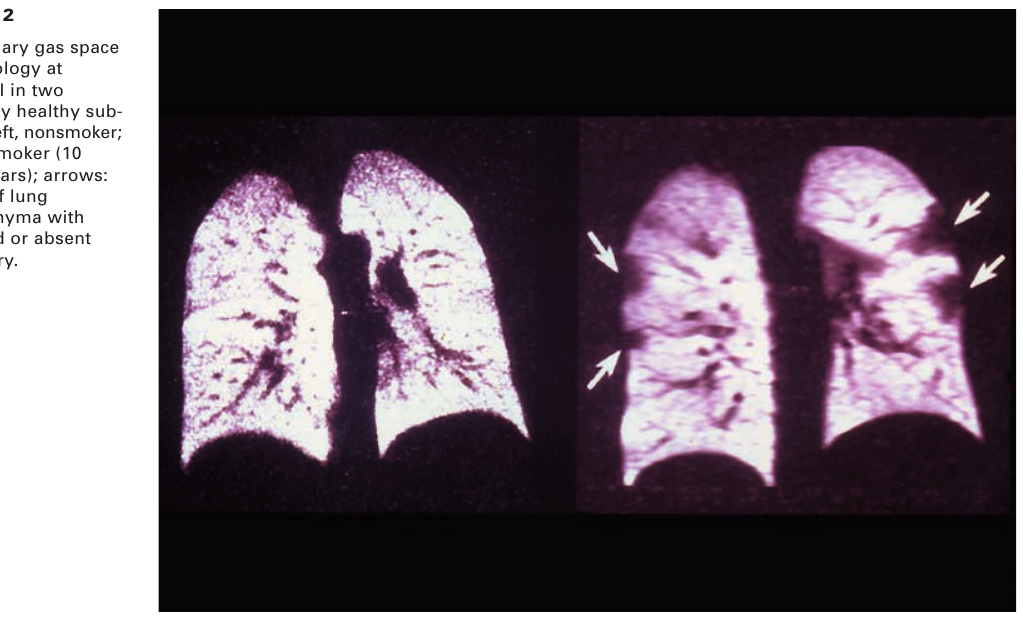
Fast dynamic 3 He MR imaging (130 ms/ image) of an inspira- tion (300 mL 3 He) in a patient with idiopathic pulmonary fibrosis (IPF) on the right and a